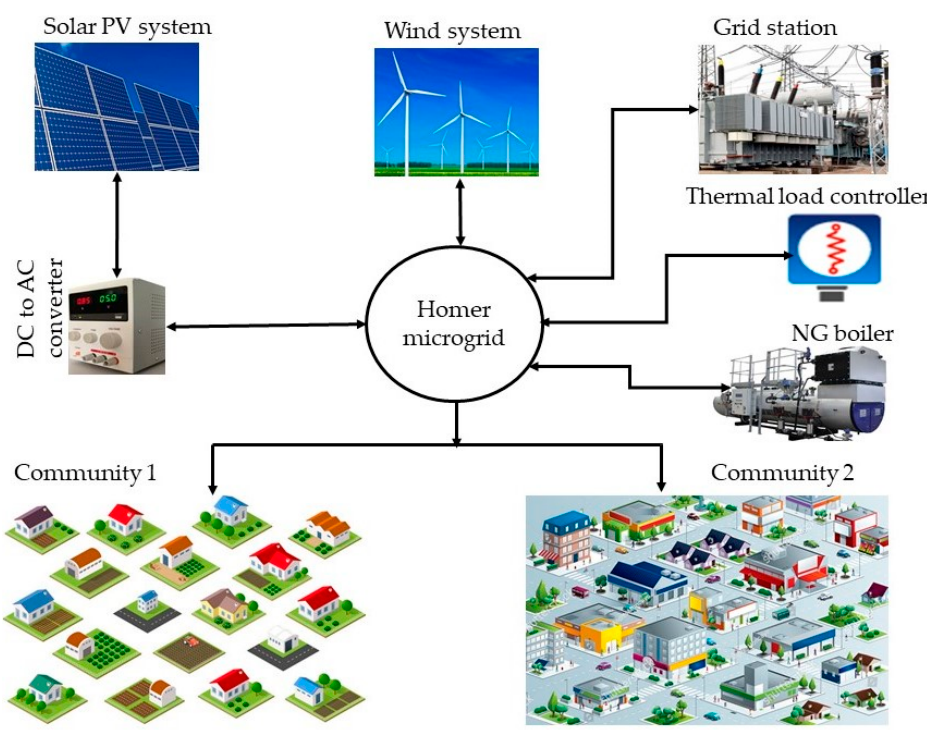
Figure 2. Schematic representation of developed energy system model.